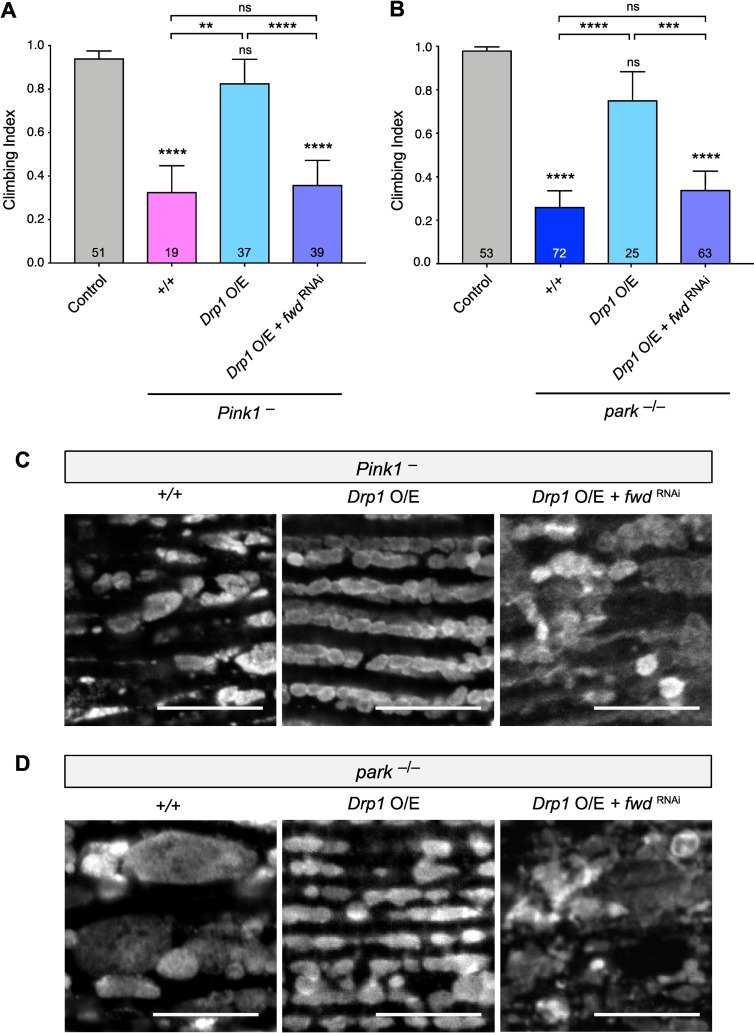
Drp1 activity requires fwd in suppressing Pink1/parkin phenotypes.(A, B) Climbing assay of control, Pink1 or parkin mutants with or without Drp1 overexpression or concomitant induction of fwd RNAi. Significance was analysed by Kruskal-Wallis test with Dunn’s post-hoc correction for multiple comparisons. Comparison is against the control unless otherwise indicated; ** P<0.01, *** P<0.001, **** P<0.0001; ns, non-significant. (C, D) Confocal microscopy analysis of mitochondrial integrity, visualised by anti-ATP5A immunostaining, in flight muscles of the indicated genotypes. For all conditions, transgenic expression was mediated via da-GAL4. Scale bar = 10 μm. Full genotypes are given in S1 Table.